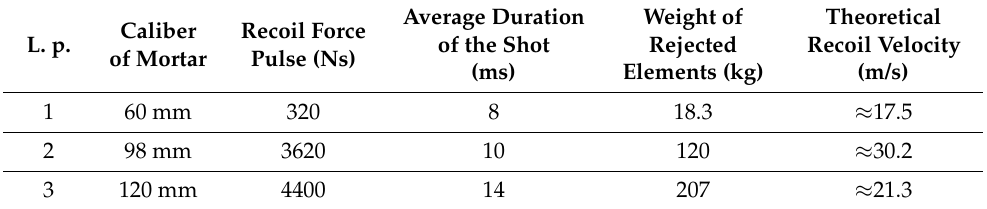
Table 1. The recoil parameters in mortars operated by the Polish Armed Forces (obtained during verification tests of mortars conducted in the Military Institute of Armament Technology). L. p.